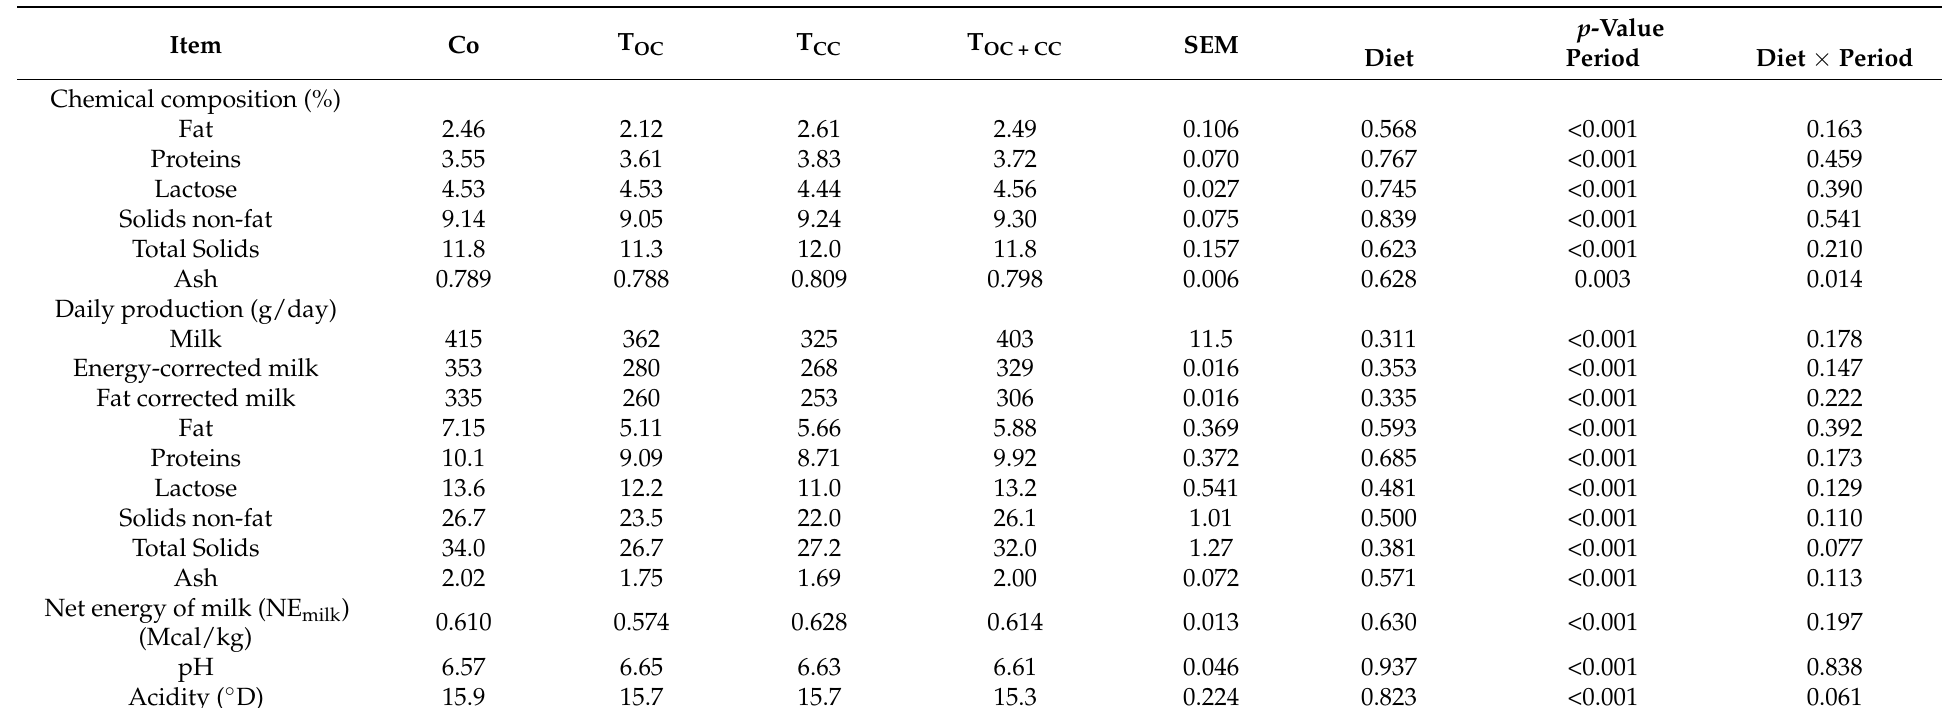
Table 3. Least squares means and standard error of the mean of daily production and composition, acidity and NE milk of goat milk according to diet (n = 220).